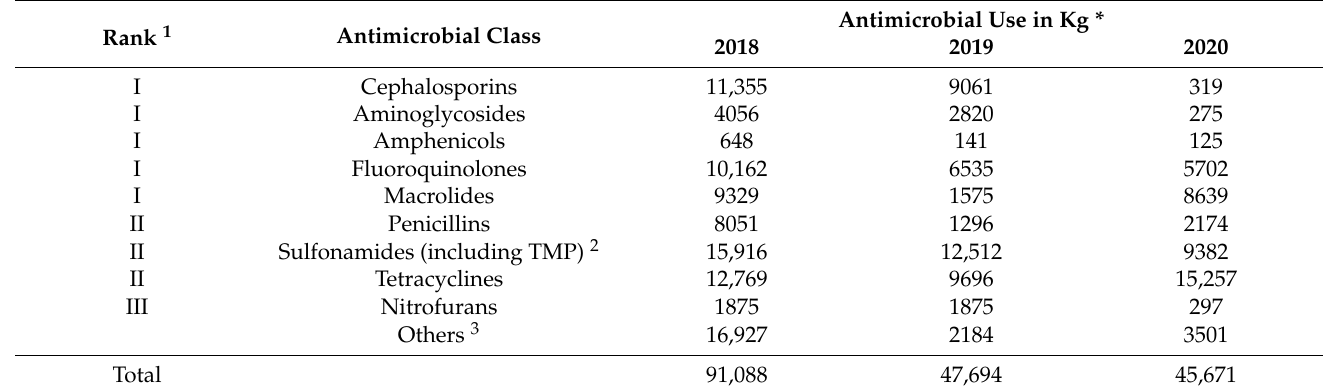
Table 1. Veterinary medical use of antimicrobials in Nepal between 2018 and